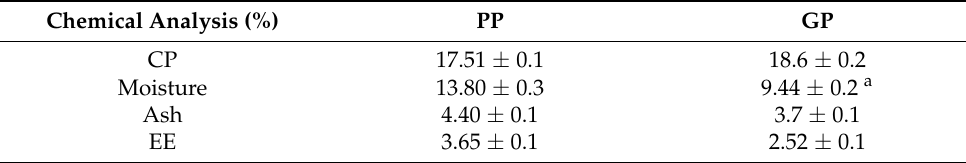
Table 1. Chemical analysis of pomegranate peel and garlic powder. Chemical Analysis (%)